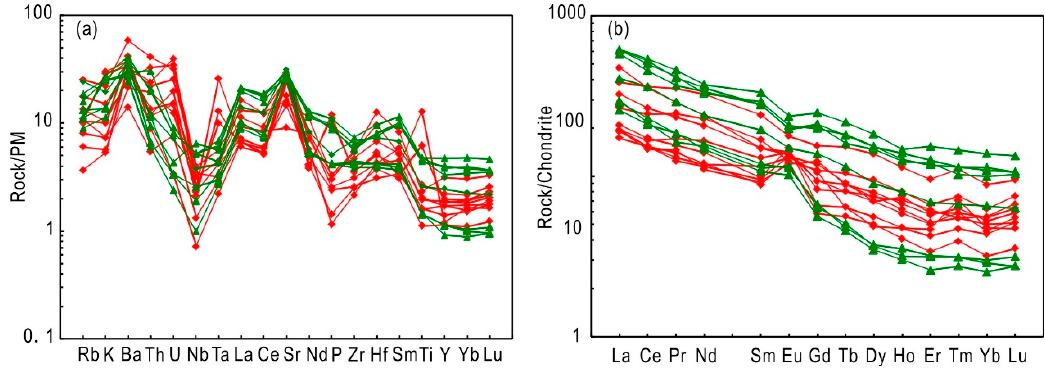
Figure 7. ( a ) PM-normalized incompatible element abundances and ( b ) chondrite-normalized REE patterns for the Haoyaoerhudong gabbro. The data for the green triangles are from [34]. The chondrite and PM values are from [37].